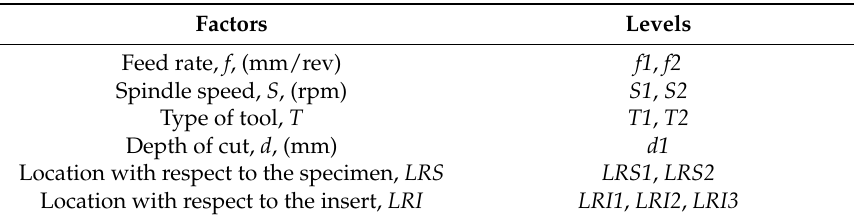
Table 1. Factors and levels. Factors